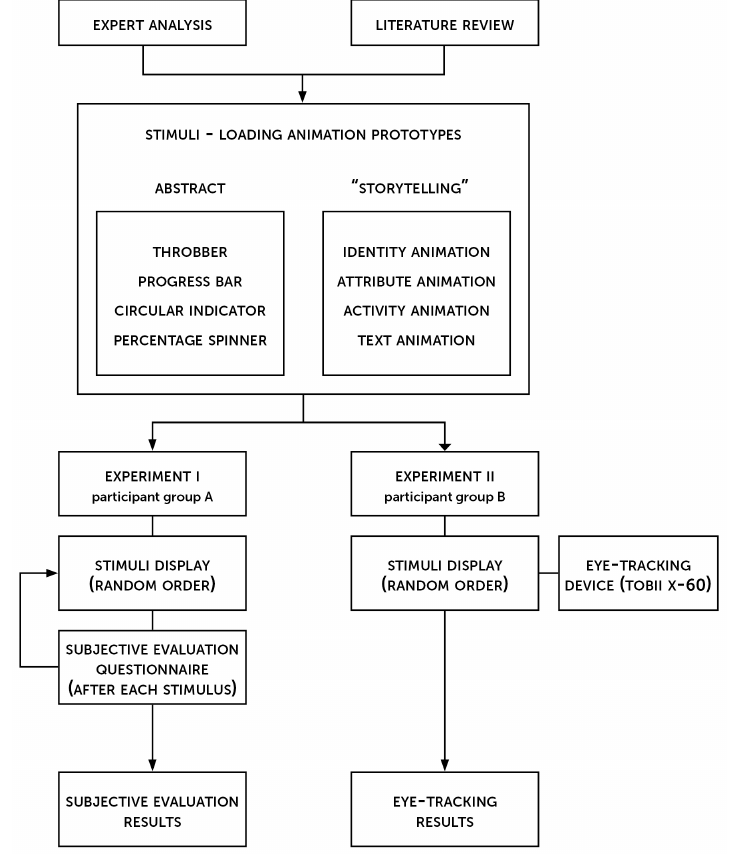
Figure 1. Flow chart of research process and methodology.